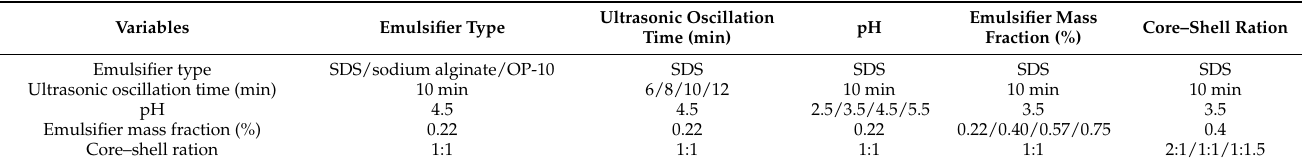
Table 3. List of all samples.